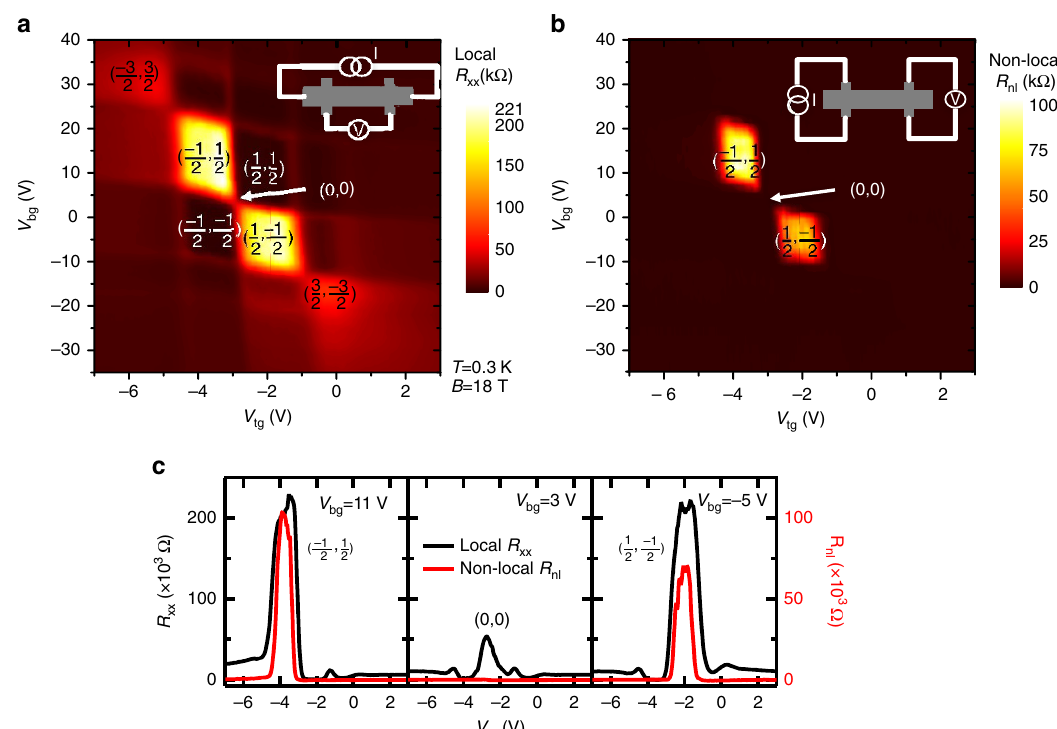
Figure 3 | Local and non-local resistance in dual-gated TI in high magnetic field. ( a ) Local resistance R xx and ( b ) non-local resistance R nl measured in sample A as functions of V tg and V bg at B ¼ 18T and T ¼ 0.3K, with insets showing the measurement setup schematics. ( c ) A few representative cuts of a and b at different values of V bg . Filing factors for the local R xx peaks are labeled in each sub-panel.